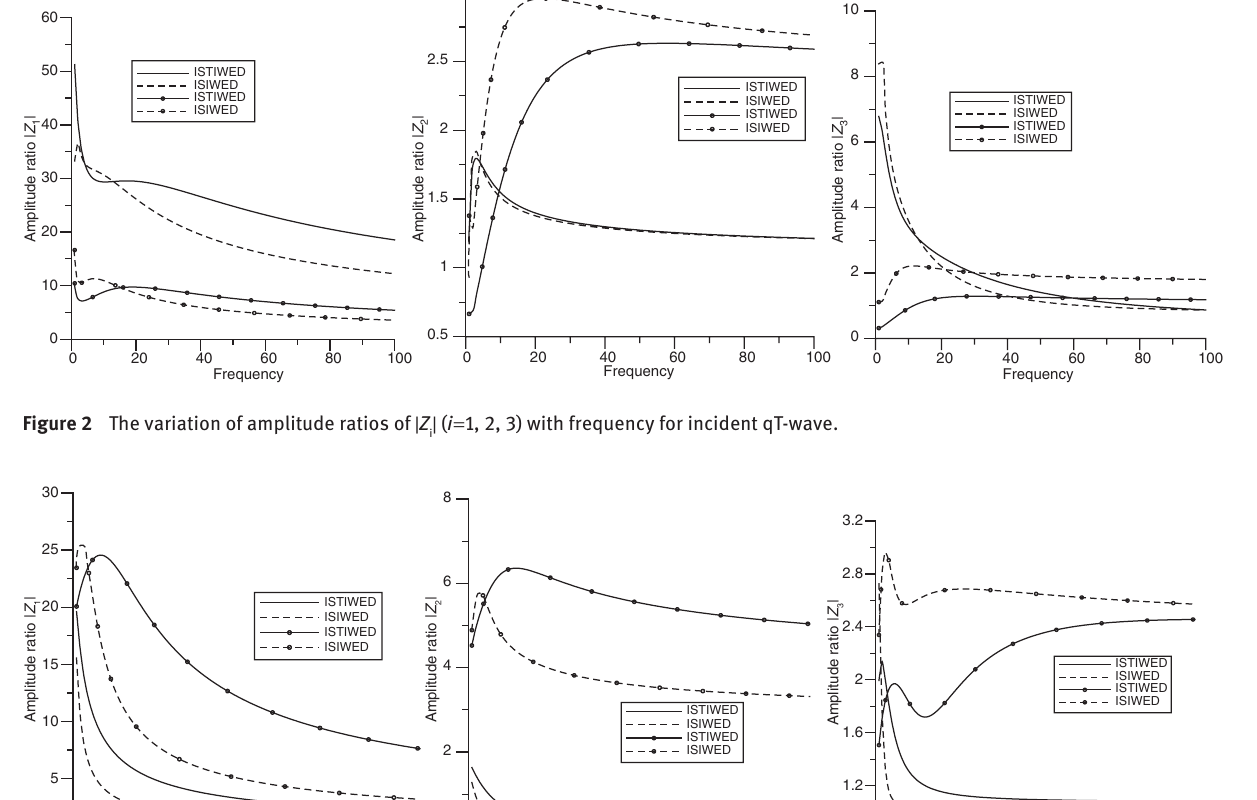
Figure 3 The variation of amplitude ratios of | Z